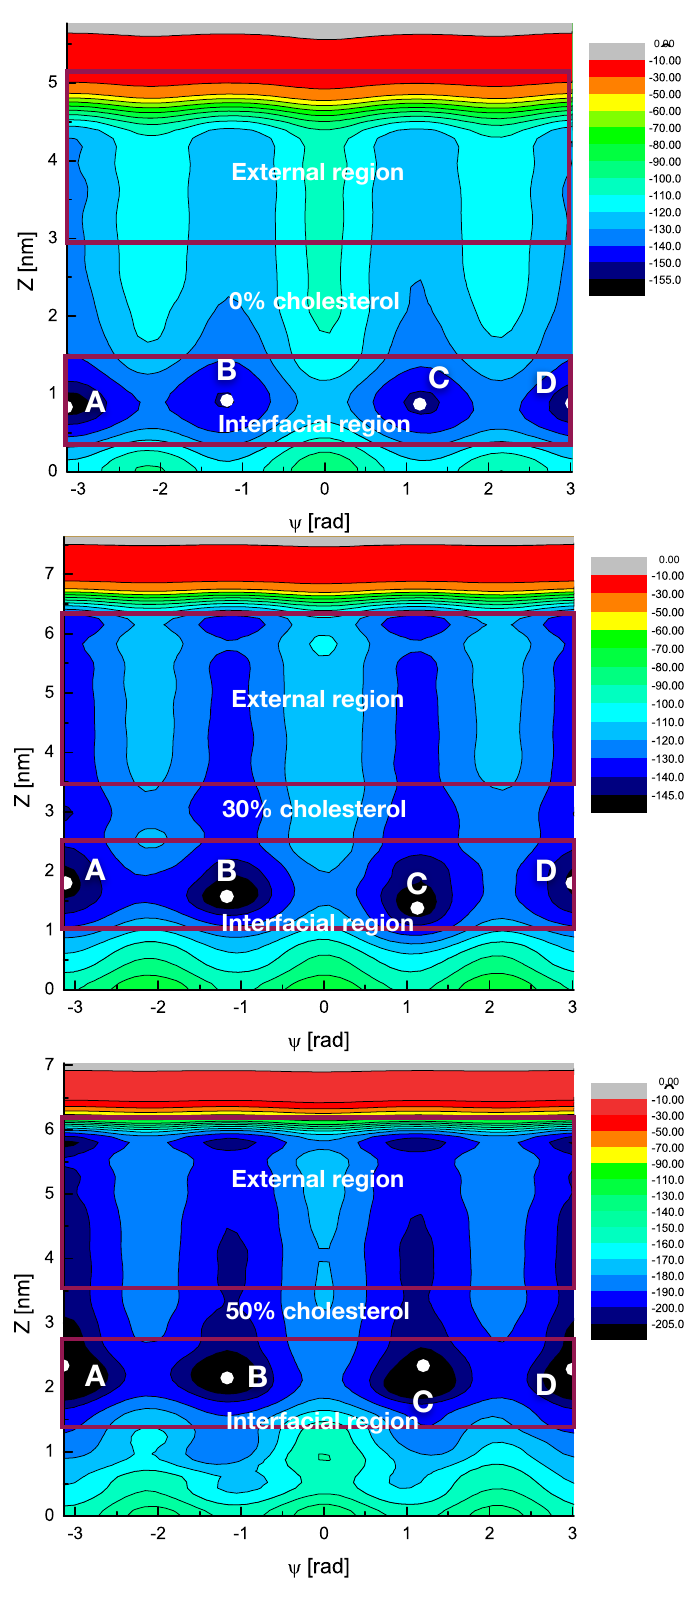
Figure 9. Two-dimensional (2D) free energy landscapes F ( Ψ , z ) (in kJ/mol) in the cholesterol-free case. Four stable state basins (A,B,C,D) are